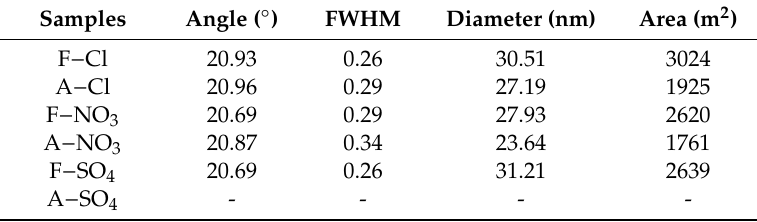
Table 1. Grain size parameters of Cu II − SSZ − 13 catalysts before and after hydrothermal aging treatment. Samples